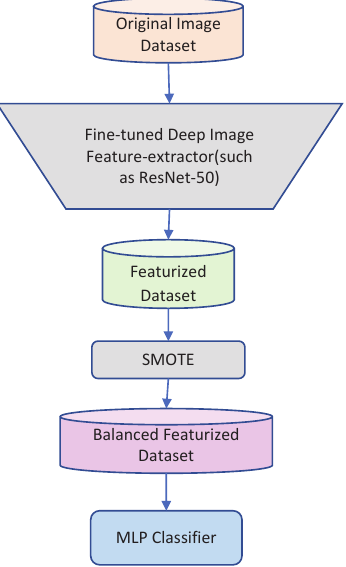
Figure 2. The figure demonstrates the integration of SMOTE into a deep learning classifier. First, the images are used to fine-tune a deep image classifier (for example, ResNet-50). The classifier’s classification layers are then removed, enabling it to function as a feature extractor. The customized deep feature extractor then maps the images to the distributed feature space. This featurized data set is subjected to SMOTE in order to increase synthetic minority class instances in order to minimize the impact of class imbalance. The multi-layer perceptron (MLP) is then used to map the class labels to the final featurized data set balanced by